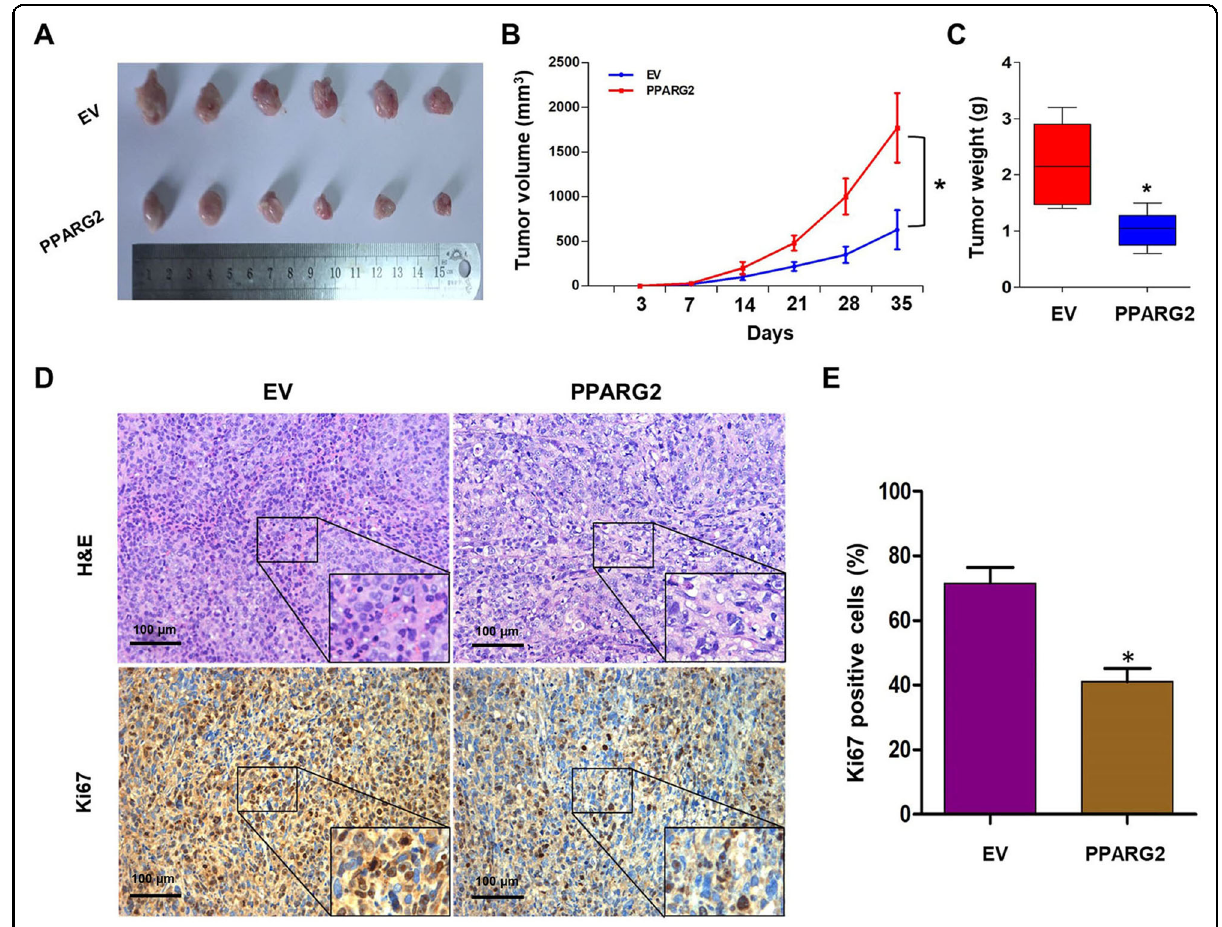
Fig. 4 PPARG2 inhibits PCA cell proliferation in vivo. A – C Representative xenograft tumors in nude mice that were injected PC3 cells subcutaneously with overexpression of transfected PPARG2 or vector cells, respectively. Tumor volumes were calculated. Tumor weights were compared between EV and PPARG2 group. * P < 0.05 vs. EV group. D , E H&E staining and Ki67 expression level of subcutaneous tumors with IHC between EV and the PPARG2 group (×100). The representative images are from the same tumor samples. * P < 0.05 vs. EV